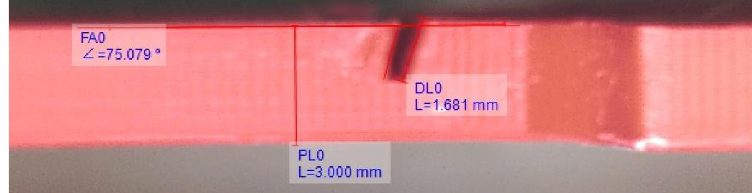
Figure 5. An example of crack dimension measurement by DinoCapture 2.0.